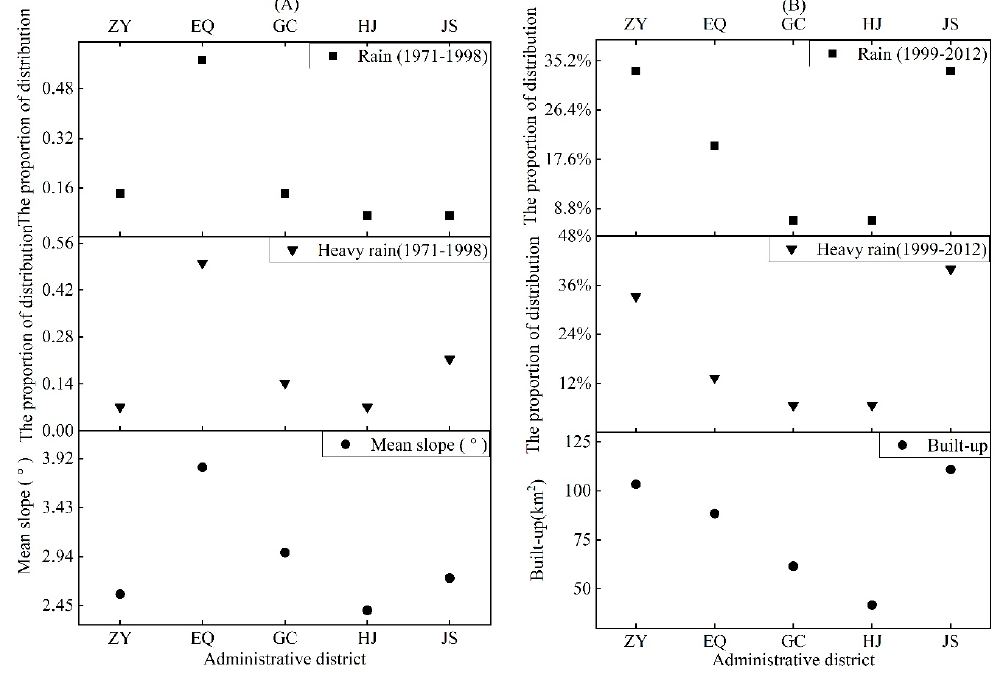
urbanization period, ( B ) relationship between built-up and precipitation center distribution during the accelerated